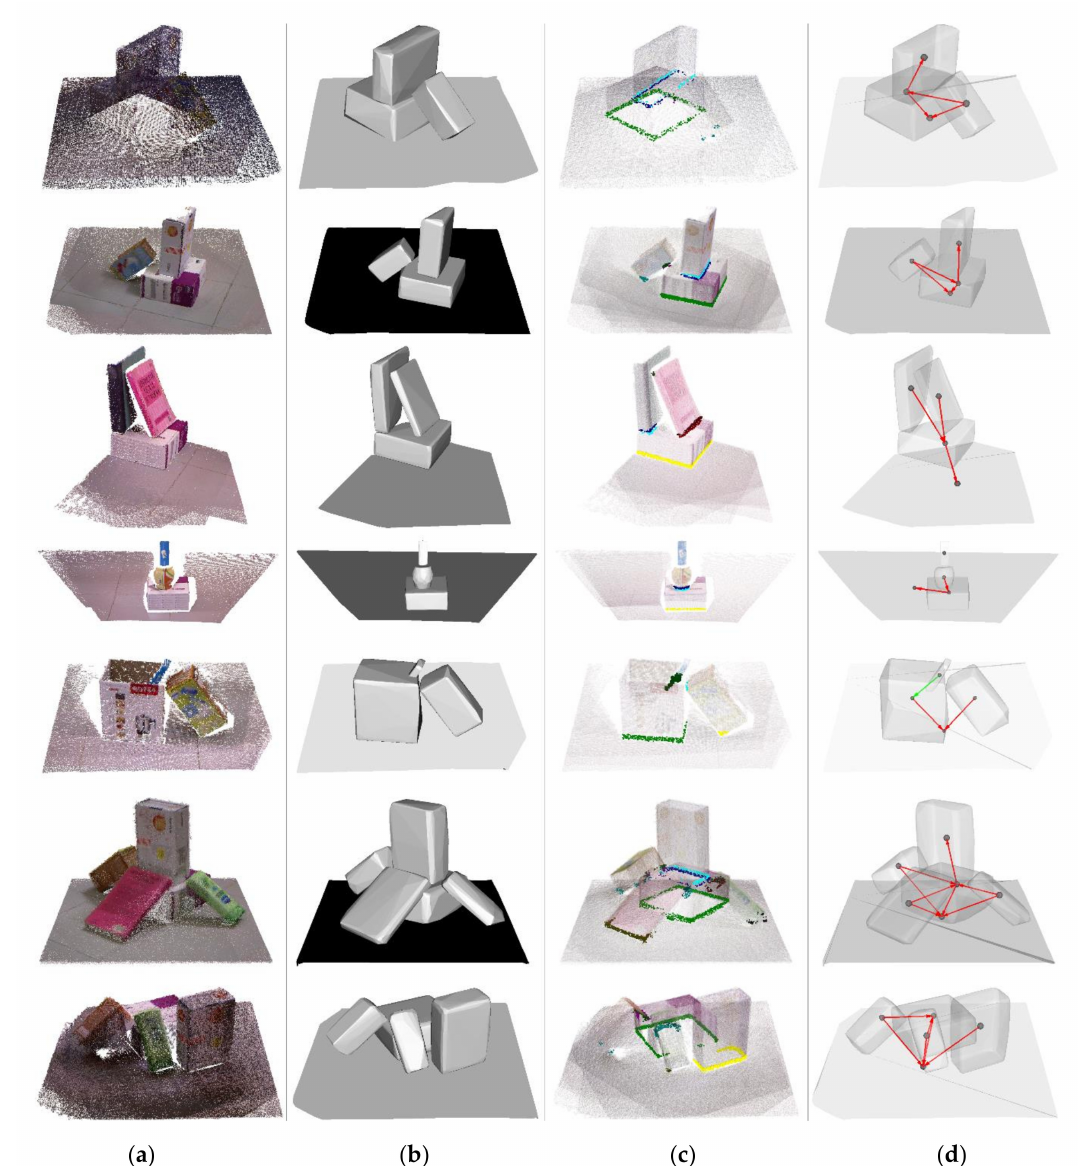
Figure 5. Visualized results of our spatial topological relation analysis on the IIIT RGBD dataset: ( a ) The original images of cluttered scenes 1 to 7; ( b ) 3D models of convex hull; ( c ) Boundary points and interior points; ( d ) Spatial topological relations between